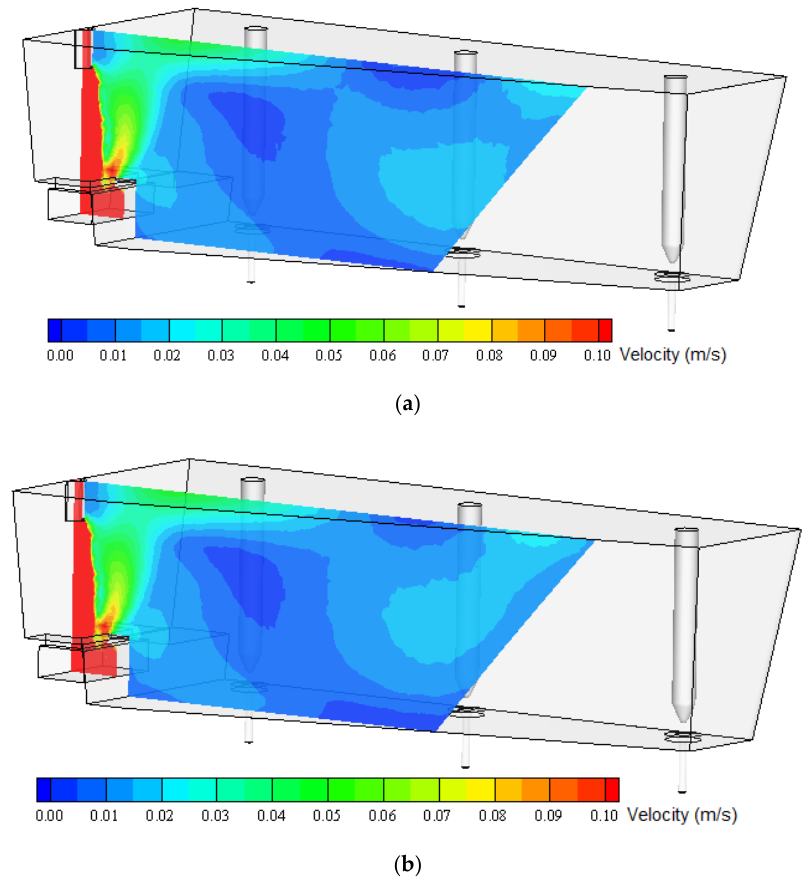
Figure 13. Numerically predicted velocity field of liquid steel in the longitudinal tundish plane passing through the shroud: ( a ) base viscosity, ( b ) experimentally obtained viscosity.